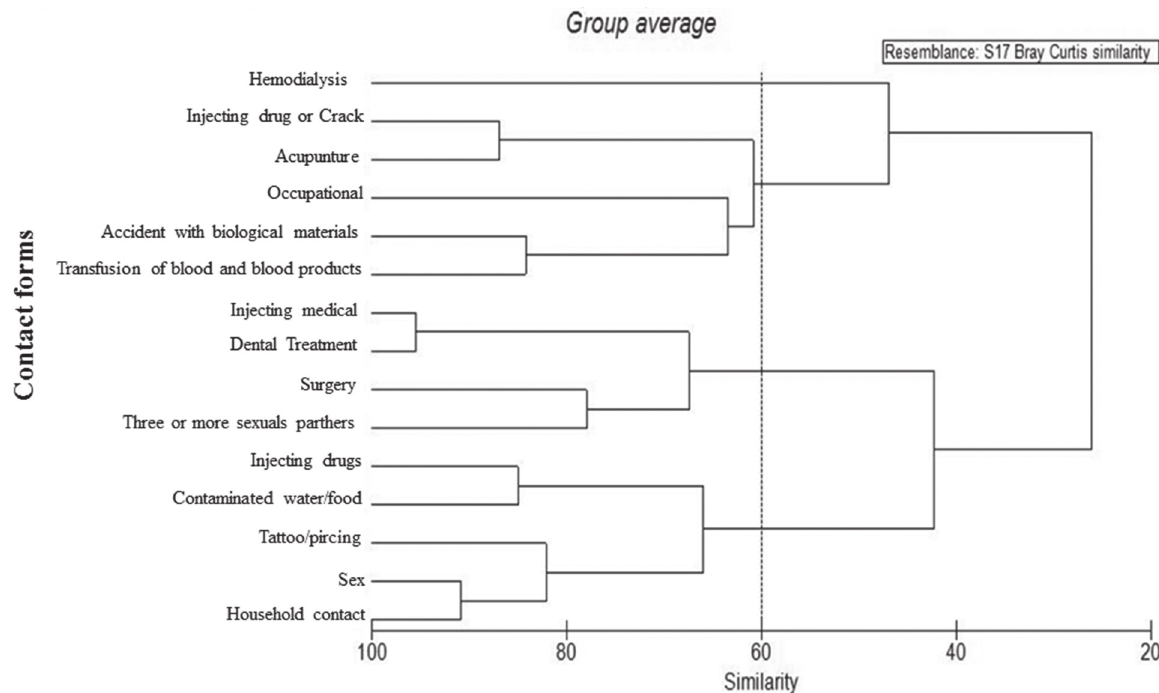
Figure 4 - Map of cities in the northern region had the highest number of notifications HBV stratified by